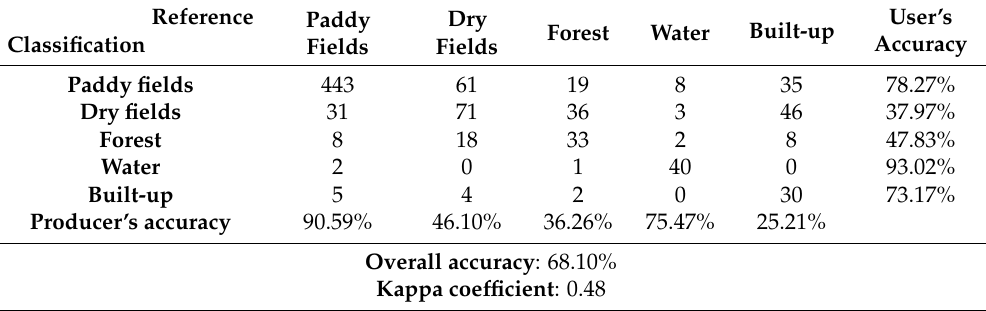
Table 4. Confusion matrix and accuracy statistics for classification using ENVISAT ASAR features.